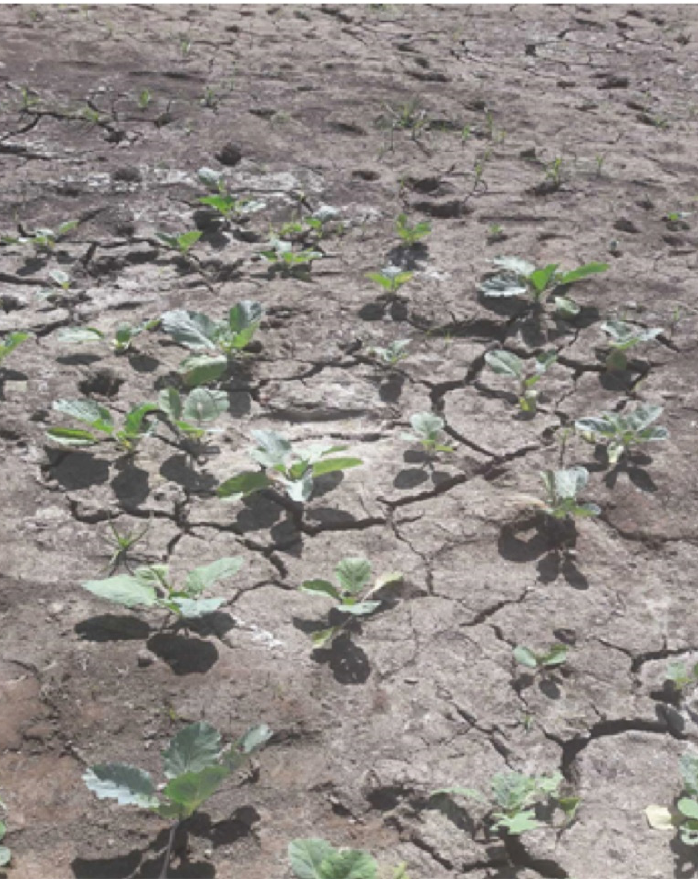
Figure 15. Image of deposition of salts and retraction cracks in the ground (Ribeira Seca river sub-basin).